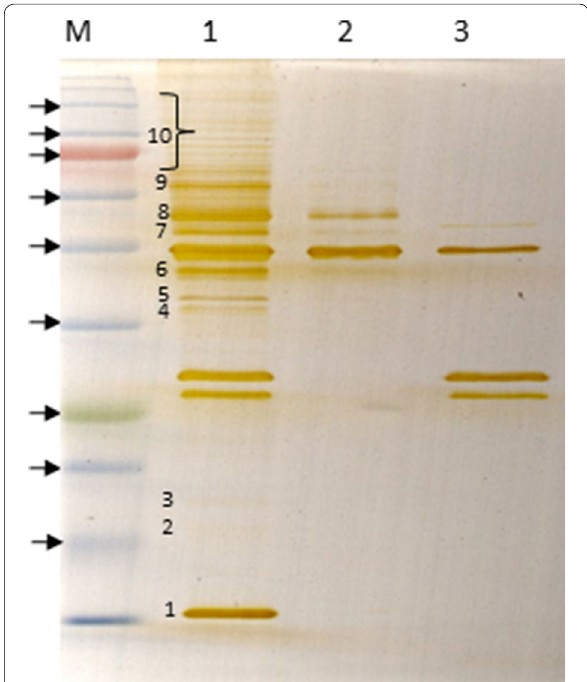
Fig. 6 Immunoprecipitation of total mouse brain proteins with Fab 65. 12% polyacrylamide gel was stained with silver ions. Lane 1: 15 μl of the immunoprecipitation reaction in the presence of mouse brain cell lysate and recombinant Fab 65 immobilized on protein L agarose beads. Lane 2: 15 μl of the pre-clearing reaction derived after incubation of the protein L agarose beads with the lysate, Lane 3: 15 μl of Fab 65 immobilized on protein L agarose. Numbers 1–10 on lane 1 indicate the excised protein bands used for mass spectrometry. Spot number 10 was considered as a single band. Arrows indicate the 17, 22, 25, 32, 46, 58, 80, 100 and 135 kDa molecular mass